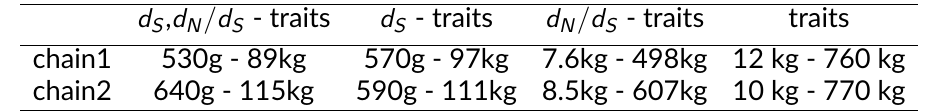
Table 2 – Estimated body mass (95% credibility interval) at the root of the Cetartio- dactyla. All coevol and the ancov analysis, that does not use molecular data, are shown.